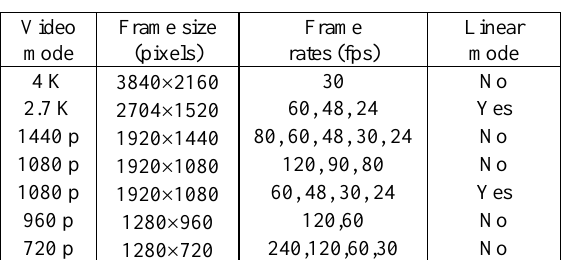
Table 1. GoPro Hero 5 Black video